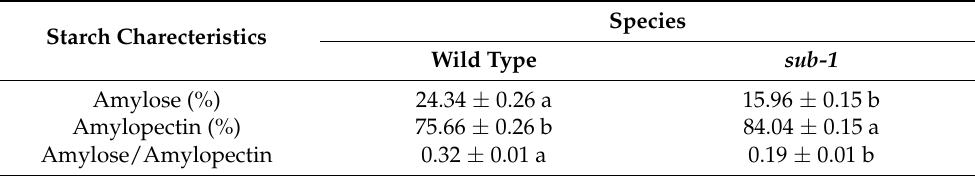
Table 1. The proportion of amylopectin in the starch of wild type and sub-1 mutant. Starch